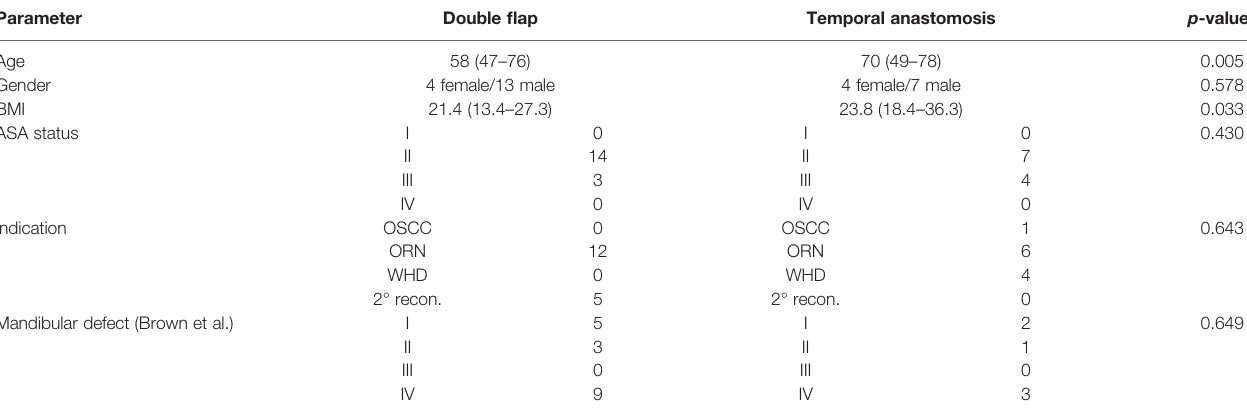
TABLE 1 | Patient records and speci fi cations of both groups [double fl ap ( n = 17) and temporal anastomosis ( n = 11)].